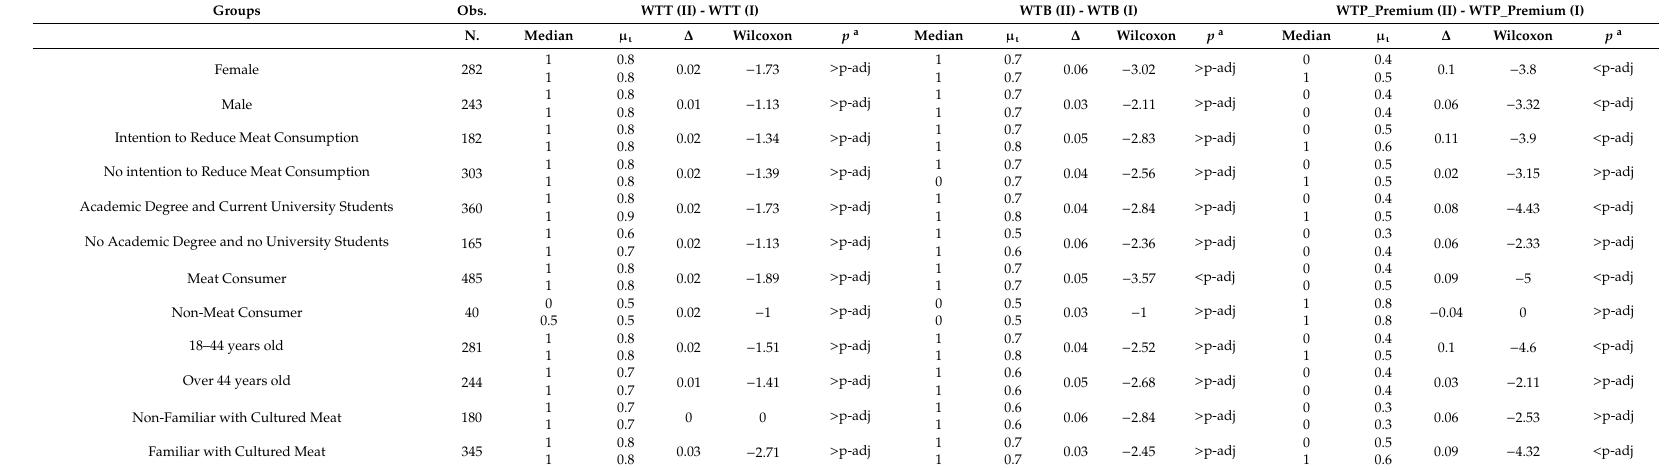
Table 5. Medians, average scores, and significance level of score di ff erences between the level II and the level I of information for WTT, WTB, and WTP a premium per